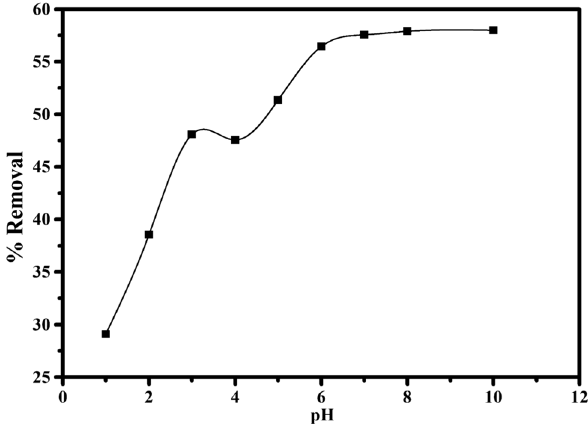
Fig. 3 Impact of solution pH on MB dye adsorption on PBF adsor- bent surface at optimum conditions (MB concentration 100 ppm, adsorbent dosage 0.2 g/l, contact time 12